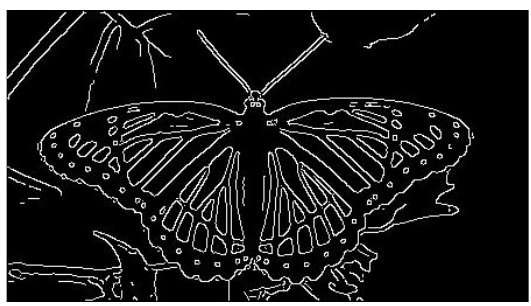
Figure 7. MATLAB result of Canny Operator.